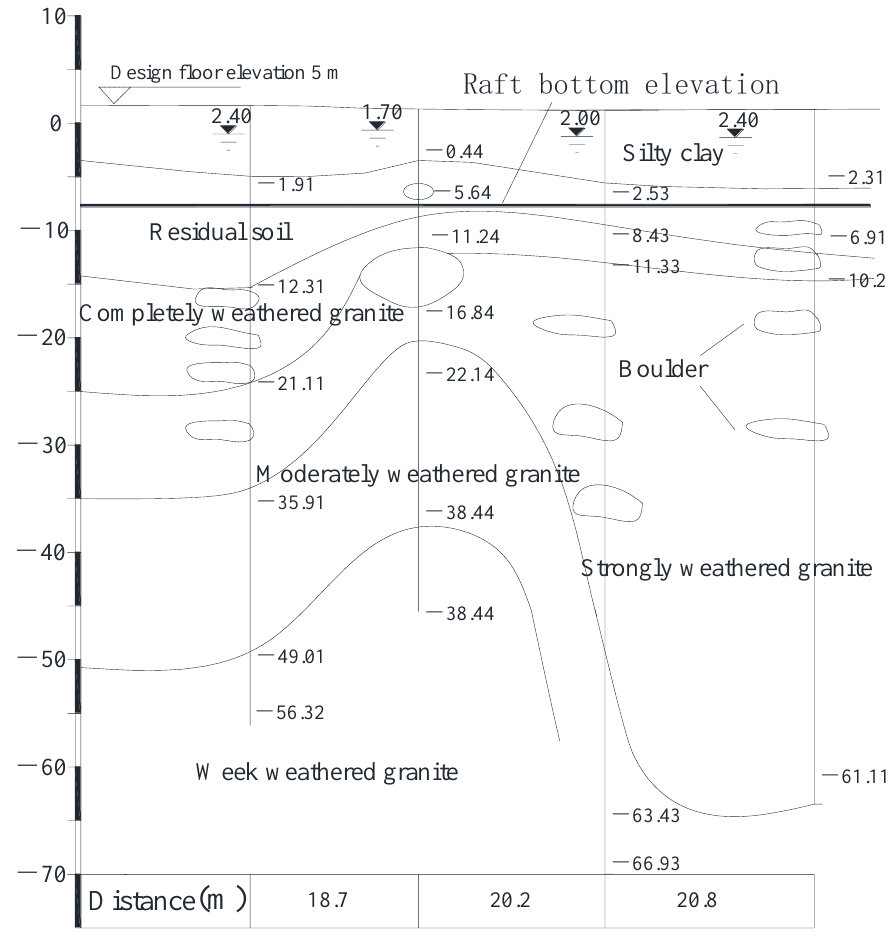
Figure 2. Typical geological section .